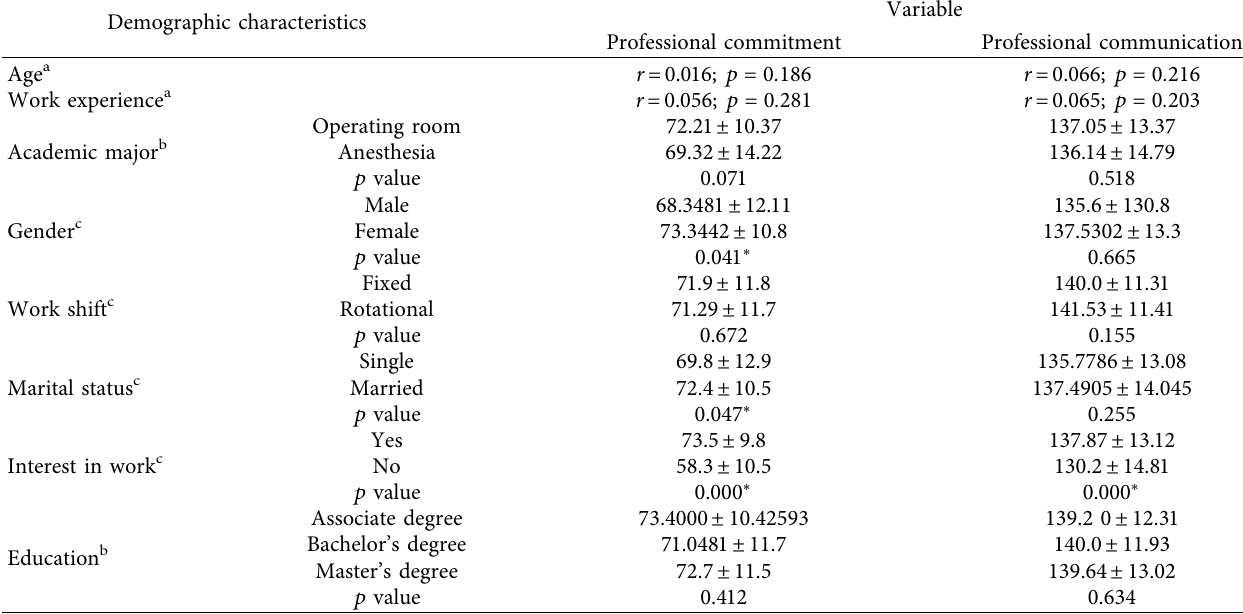
Table 4: The relationship between the participants’ professional communication and professional commitment mean scores and their demographic